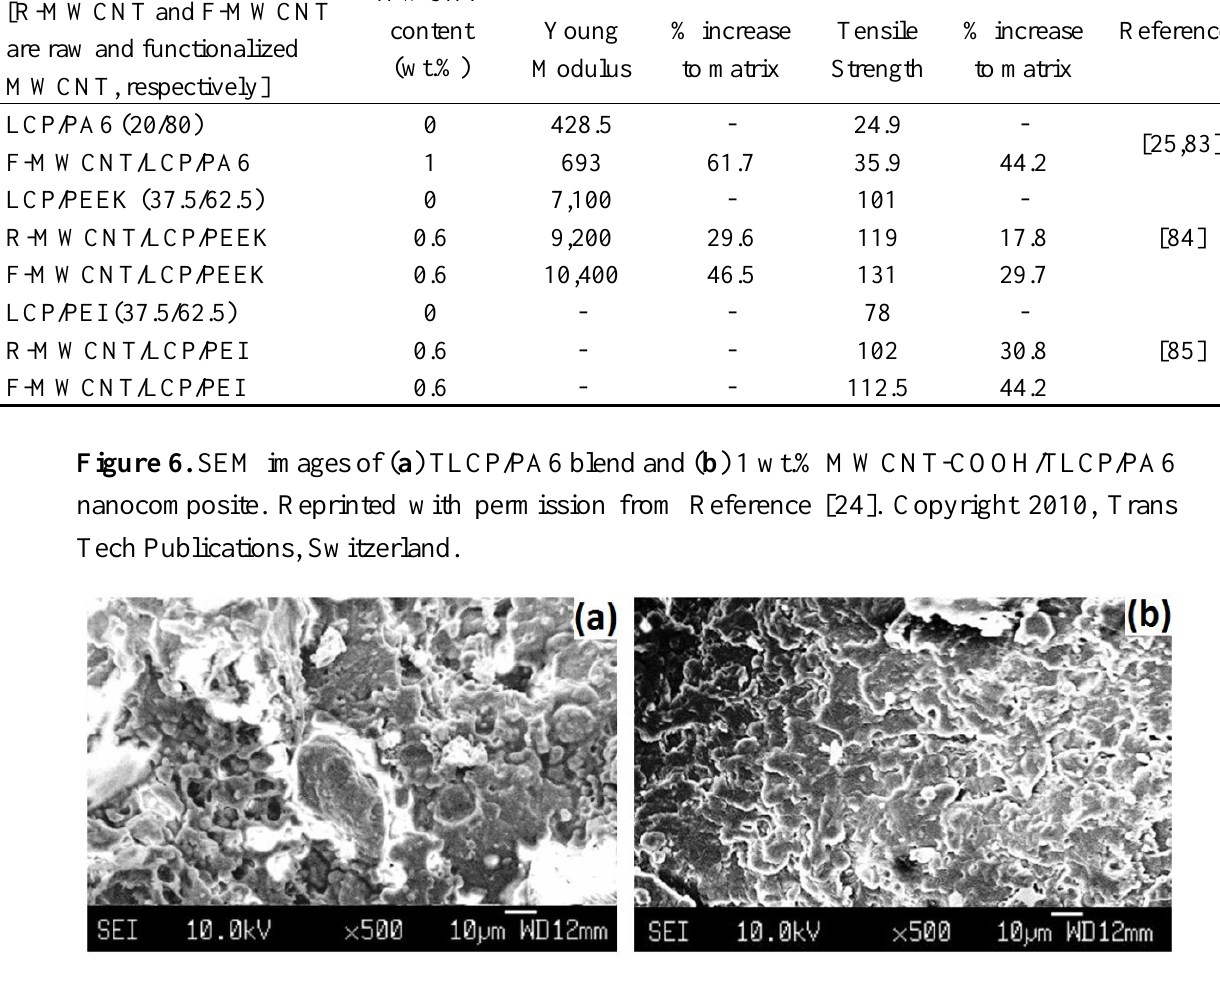
Table 5. Enhancement of the mechanical properties of TLCP/polymer blend with and without incorporating raw and functionalized MWCNTs.